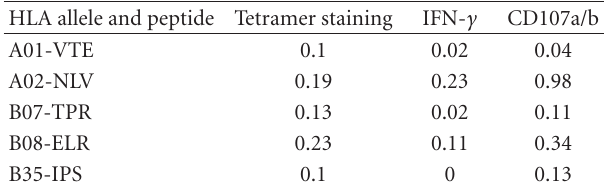
Table 4: Analytical sensitivity. Values represent number of cells per μ L of blood. HLA allele and peptide Tetramer